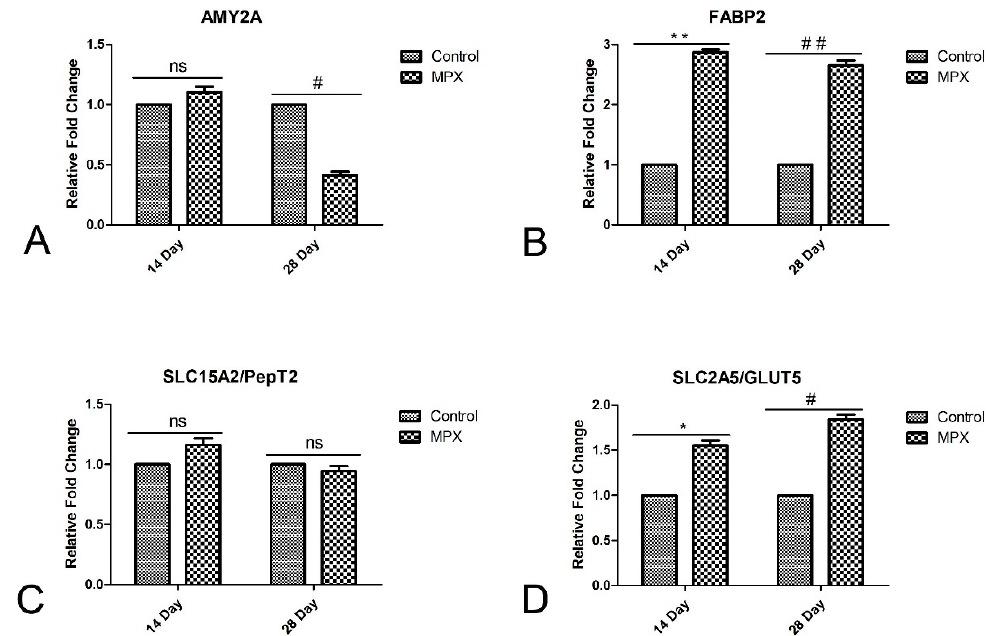
Figure 5. mRNA expression of nutrient transporters and digestive enzymes in the intestine of MPX- supplemented broiler chickens at 14 d and 28 d. ( A ) mRNA expression of AMY2A in chickens at 14 d and 28 d. ( B ) mRNA expression of FABP2 in chickens at 14 d and 28 d. ( C ) mRNA expression of SLC15A2/PepT2 in chickens at 14 d and 28 d. ( D ) mRNA expression of SLC2A5/GLUT5 in chickens at 14 d and 28 d. ns represents no significant difference between control group and MPX group; # represents significant difference between control group and MPX group at 28 d, p < 0.05; ## represents significant difference between control group and MPX group at 28 d, p < 0.01; * represents significant difference between control group and MPX group at 14 d, p < 0.05; ** represents significant difference between control group and MPX group at 14 d, p < 0.01.